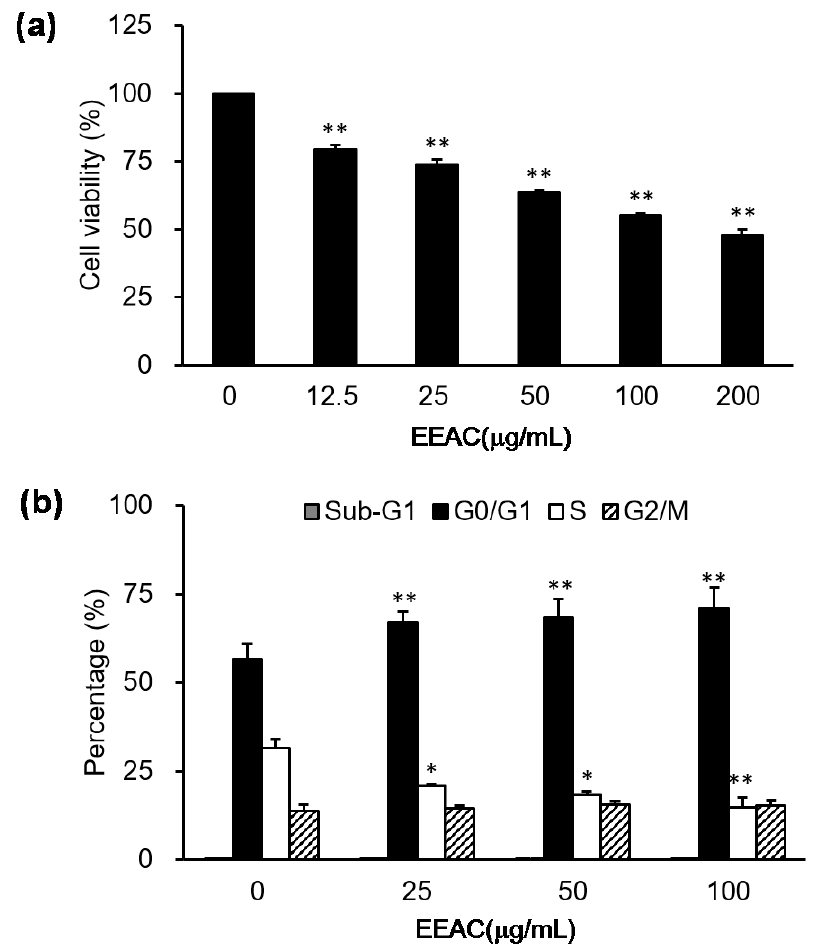
Figure 1. Growth regulation of ethanolic extracts from Antrodia cinnamomea (EEAC) in A549 cells. Cell viability and cell cycle distribution were, respectively, measured using an (3-(4,5-Dimethylthiazol-2-yl)-2,5-diphenyltetrazolium bromide) (MTT) assay ( a ) and a flow cytometer ( b ) in A549 cells treated with various concentrations of EEAC for 24 h.* p < 0.05 and ** p < 0.01 compared to the control group (without EEAC treatment), respectively.